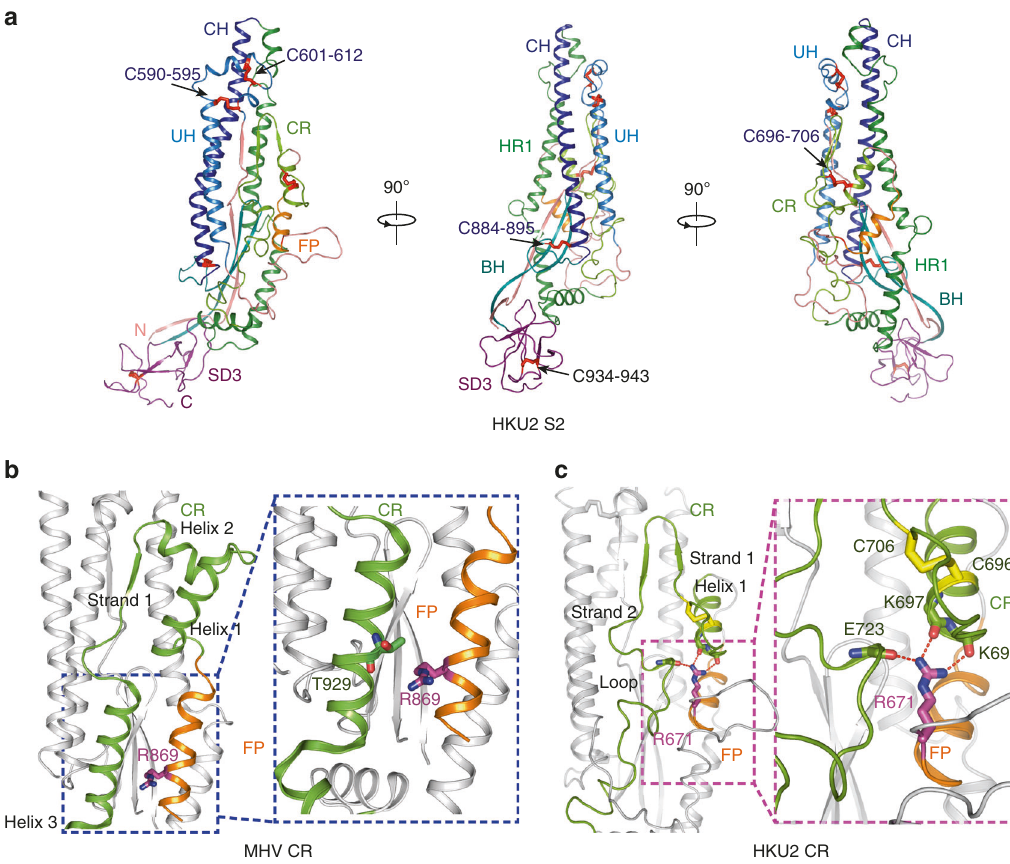
Fig. 6 Structure of HKU2 S2. a Side views of HKU2 S2 shown in three directions. Seven segments of S2 are shown as different colors. UH upstream helix, FP fusion peptide, CR connecting region, HR1 heptad repeat 1, CH central helix, BH β -hairpin, SD3 subdomain 3. Disul fi de bonds are shown as red sticks. Disul fi de bonds conserved in all coronaviruses are labeled blue; the other disul fi de bond is labeled black. b Conserved CR represented by MHV CR. CR and FP are colored the same as in a . Helices and strands in CR are labeled. R869 (S2 ′ cleavage site) is shown as stick and colored magenta. The blue dashed box shows R869 does not interact tightly with MHV CR. PDB code: MHV, 3JCL. c Unique feature of HKU2 CR. CR and FP are colored the same as in a . Helices and strands in CR are labeled. R671 (S2 ′ cleavage site) is shown as stick and colored magenta. The magenta dashed box shows detailed interactions between R671 and